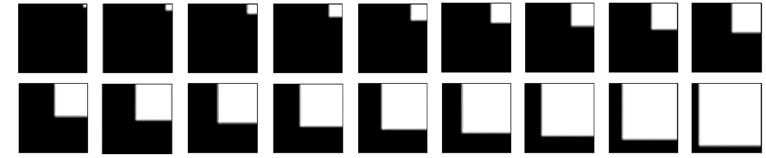
Figure 7. Test images with different grayscale distributions.